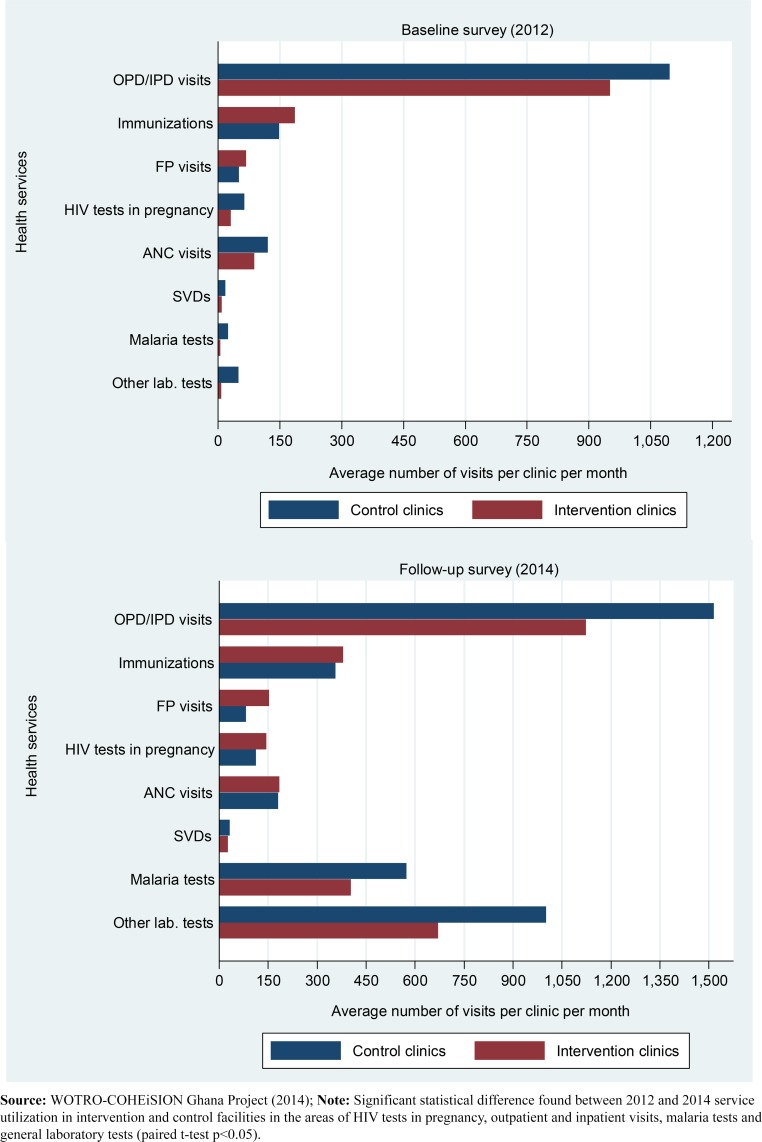
Service utilization in intervention and control facilities in 2012 and 2014.
Legend: OPD (outpatient department); IPD (Inpatient department); FP (Family planning); SVDs (Spontaneous vaginal deliveries); HIV (Human Immuno-deficiency virus); ANC (antenatal care).